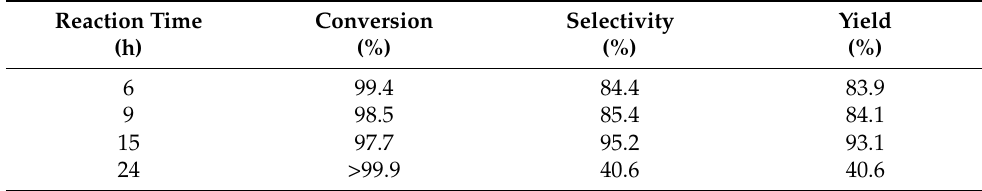
Figure 13. The histograms of the PC yield for CO 2 /PO cycloaddition reactions using the APTMS- modified Zr–Mg mixed oxide aerogels with Zr/Mg molar ratio of 7/3 under different reaction times. Table 5. The PO conversion, PC selectivity, and PC yield using the APTMS-modified Zr–Mg mixed oxide aerogels with Zr/Mg molar ratio of 7/3 under four APTMS modifications and reaction temperature of 150 °C at different reaction times.